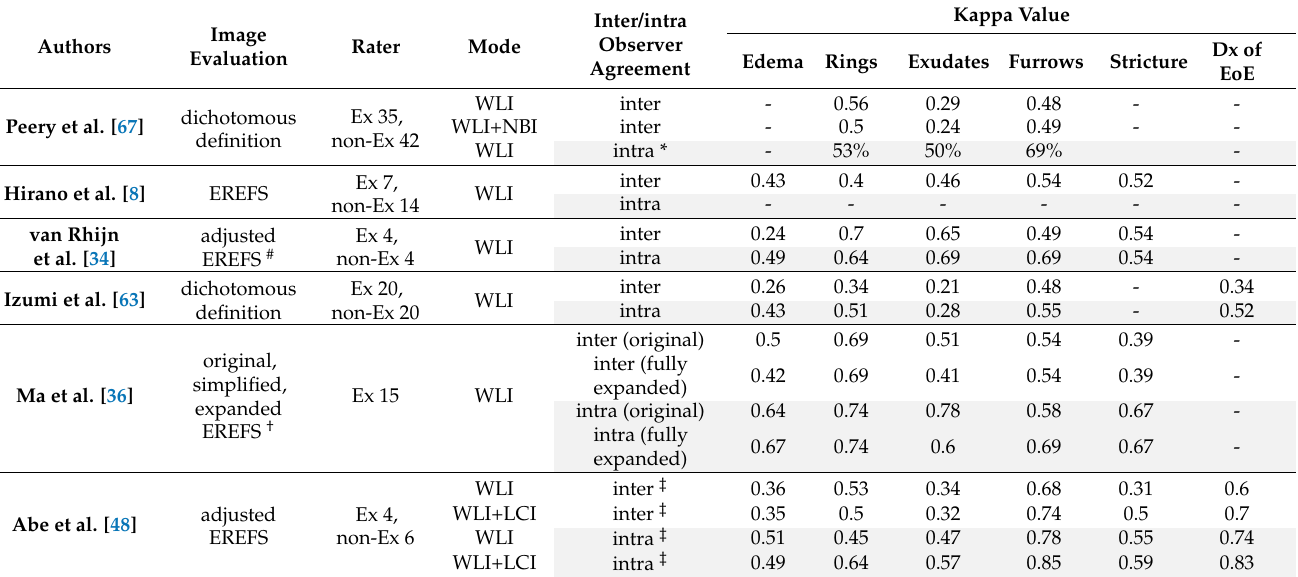
Table 2. Inter- and intraobserver agreement in the endoscopic diagnosis for EoE.